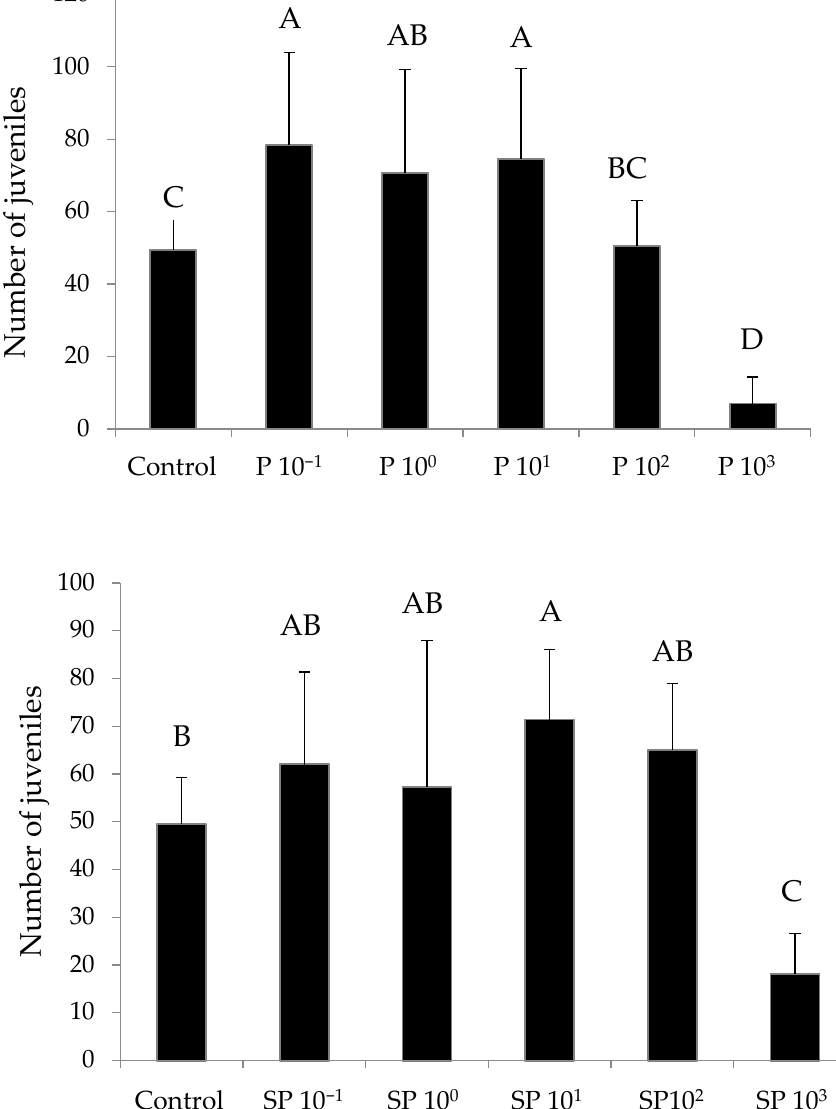
Figure 1. Toxicity test 1. Mean number of E. fetida juveniles produced during the time of the experiment per test vessel on day 56 in the presence of increasing concentrations of PROSARO ® (P, above ) and SWING PLUS ® (SP, below ). See Table 1 for specifications on concentrations. Error bars represent standard deviation. Means with different letters are significantly different ( p < 0.05). Table 6. The 20% and 10% inhibition concentrations (IC 10 and IC 20 ) and estimations (IC95%) for two fungicide formulations considering performance in terms of number of juveniles. Based on results from Toxicity test 1.